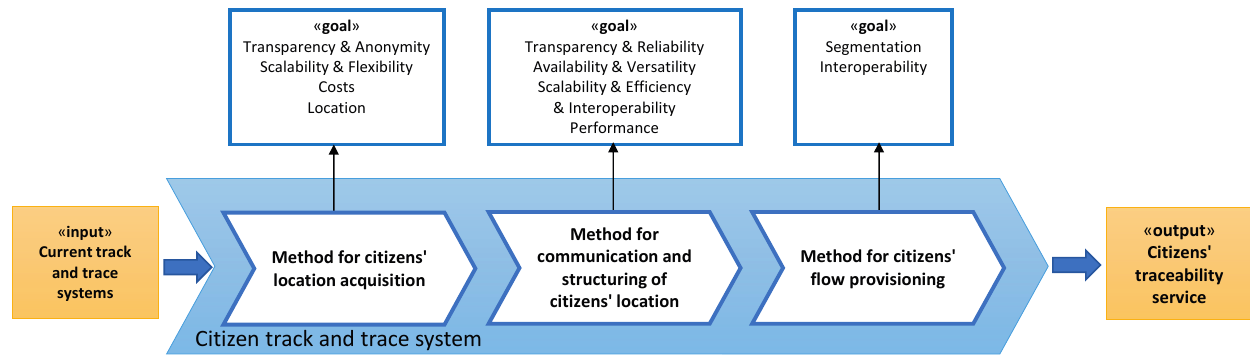
Figure 1. Modelling with Eriksson-Penker notation of the process of obtaining citizen movements flows.